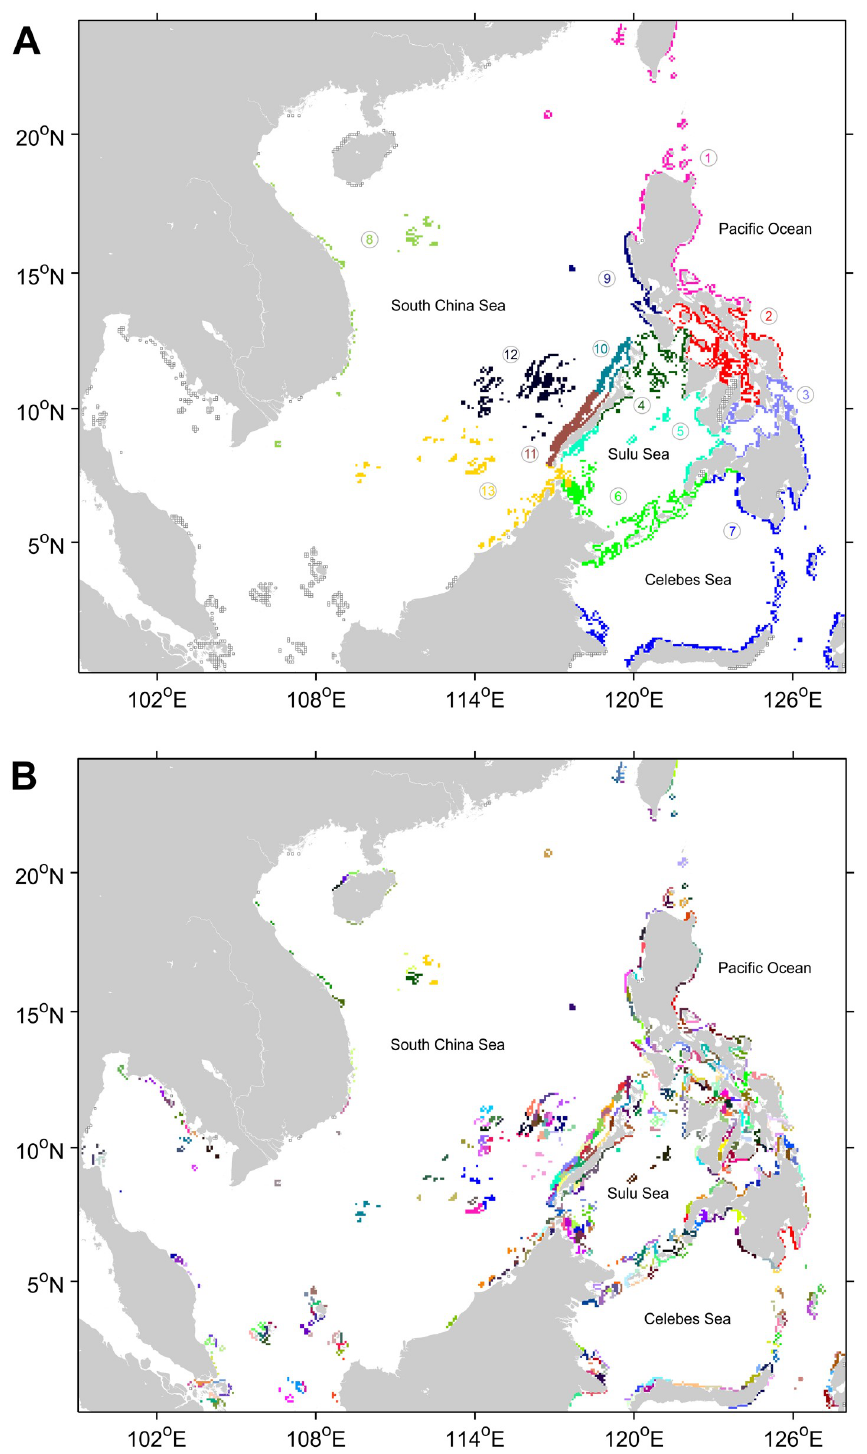
Fig 5. Clusters of covarying connectivity patterns based on the Bray-Curtis Dissimilarity matrix of the source and sink connections of the three model organisms. The dendrogram was cut at (A) MCS = 100 and (B) MCS = 5. Each color represents a unique cluster. Reefs boxed in gray were outliers excluded from the clustering. Clusters identified in (A) are (1) Northern Luzon and Taiwan, (2) Philippine internal seas and San Bernardino Strait, (3) Bohol Sea and Surigao Strait, (4) Northern Sulu Sea, (5) Central Sulu Sea, (6) Southern Sulu Sea, (7) Celebes Sea, (8) Vietnam and